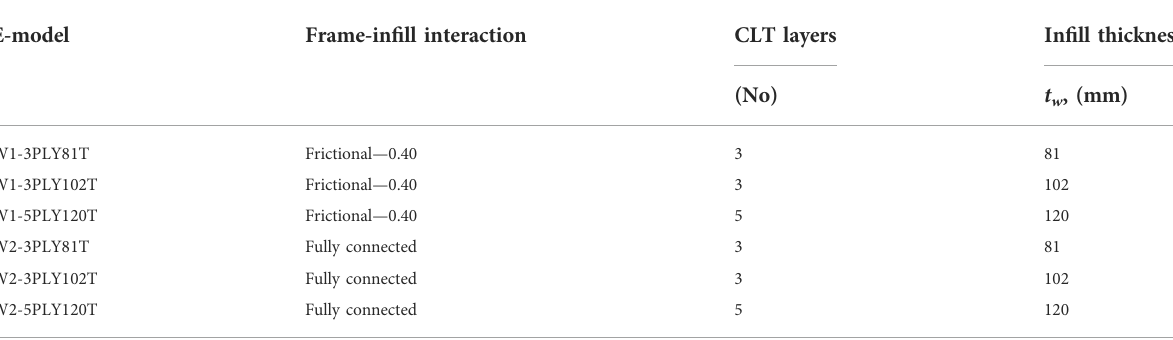
TABLE 1 Speci fi cations of STSW